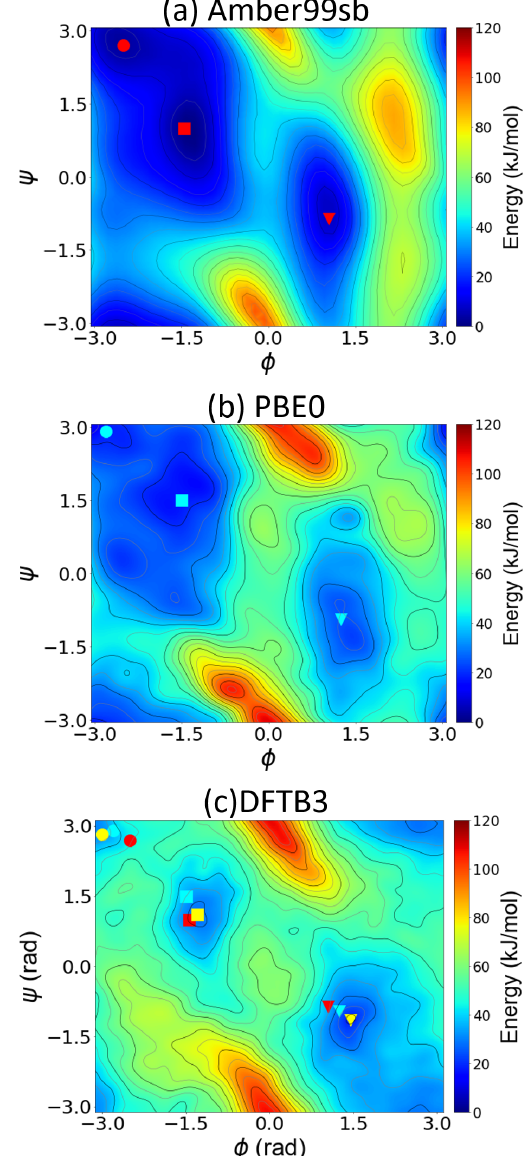
Figure 3. Two-dimensional potential energy surface of alanine dipeptide as a function of the backbone dihedral angles, φ and ψ , obtained from well-tempered metadynamics simulations using ( a ) classical MD from the Amber99sb force field, ( b ) DFT-PBE0 calculations, and ( c ) SCC-DFTB3 calculations. The red, cyan, and yellow points in panels ( a – c ) represent the local minima obtained using the Amber99sb force field, PBE0, and SCC-DFTB3, respectively. ● , ■ , and ▼ denote the positions of the local